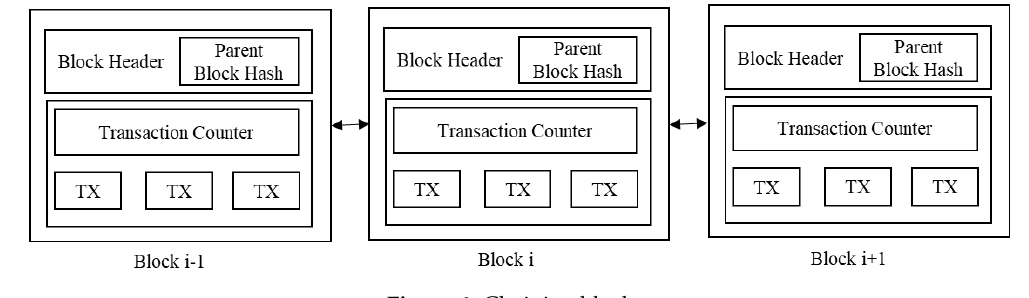
Figure 6. Chaining blocks.